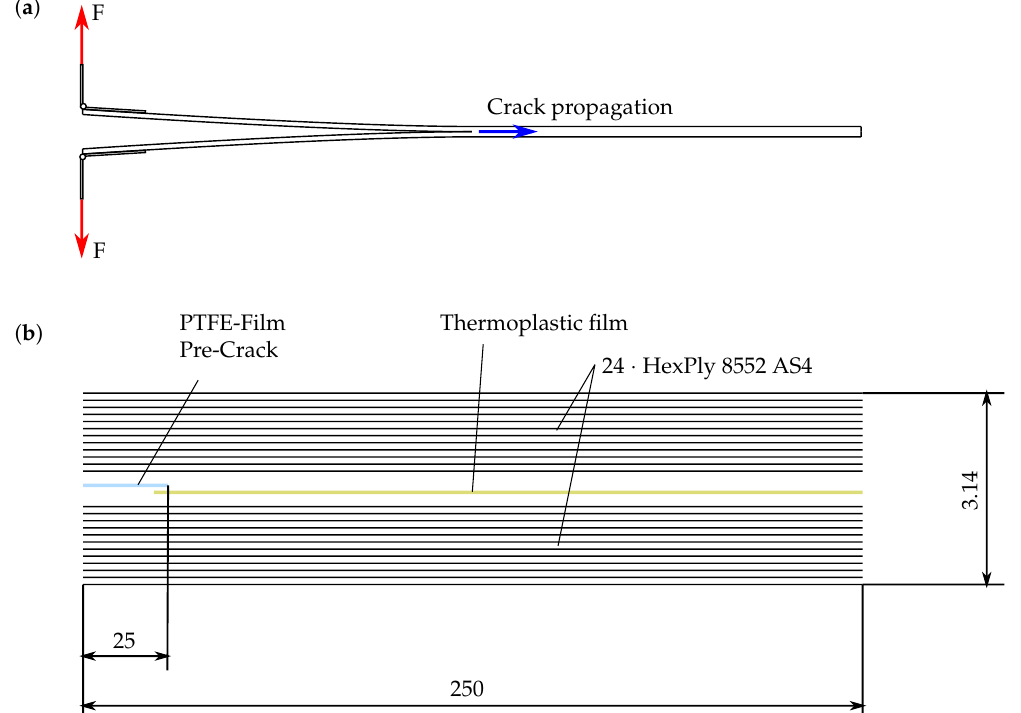
Figure 5. Testing and layup of double cantilever beam test specimens: ( a ) Shematic of a Double Cantilever Beam (DCB) specimen with glued piano hinges in the test setup. ( b ) Layup and geometry DCB